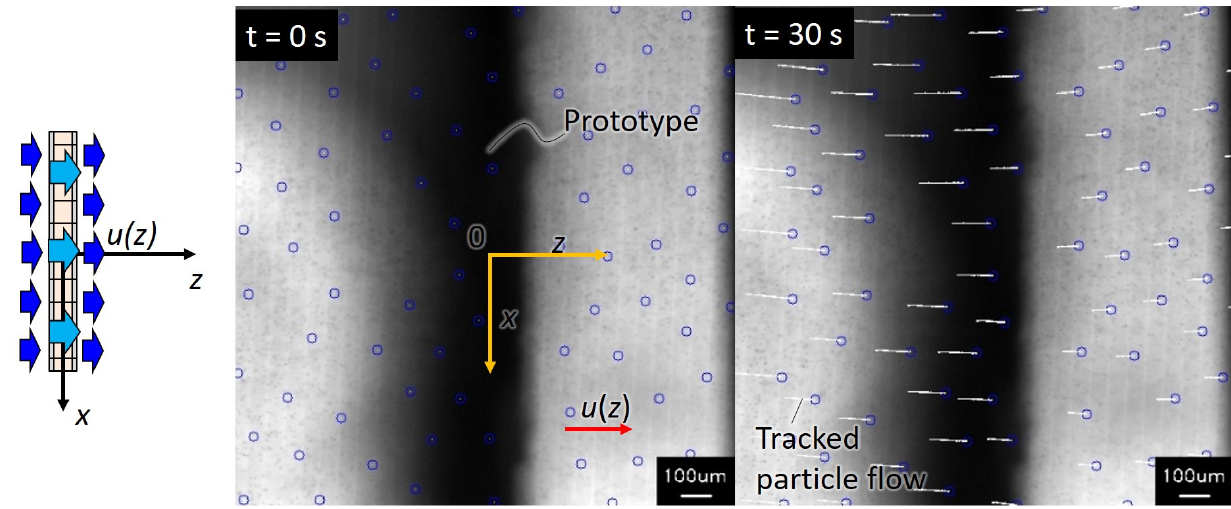
Figure 10. Snapshots from an observed video using optical-flow processing in “OpenCV”. The blue points and white curves represent tracked particles and their trajectories, respectively, and their mean